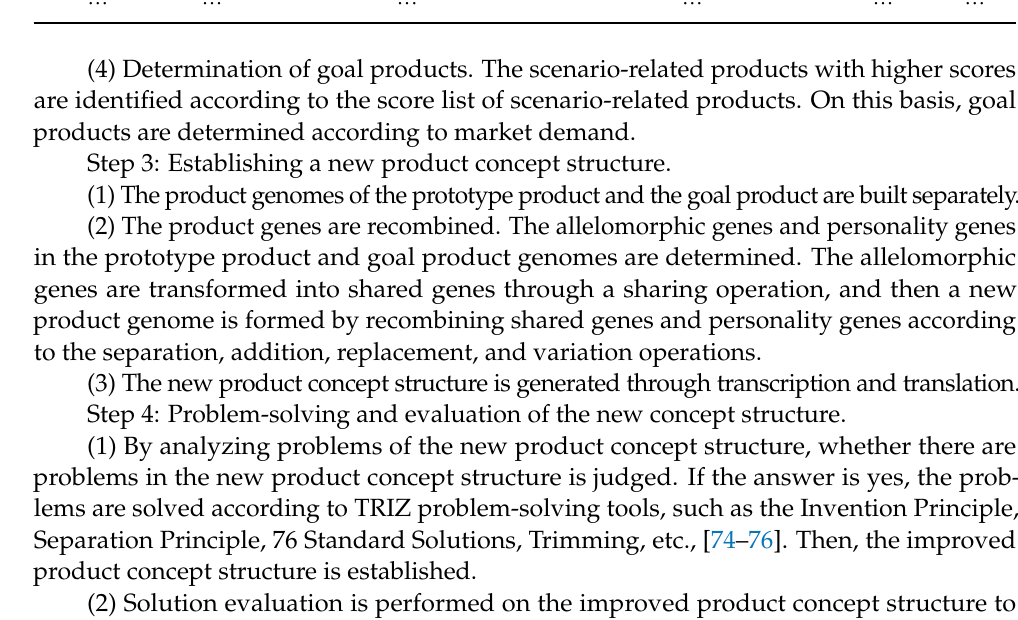
Table 1. Score list of scenario-related products. Number Function Scenario-Related Product Occurrence